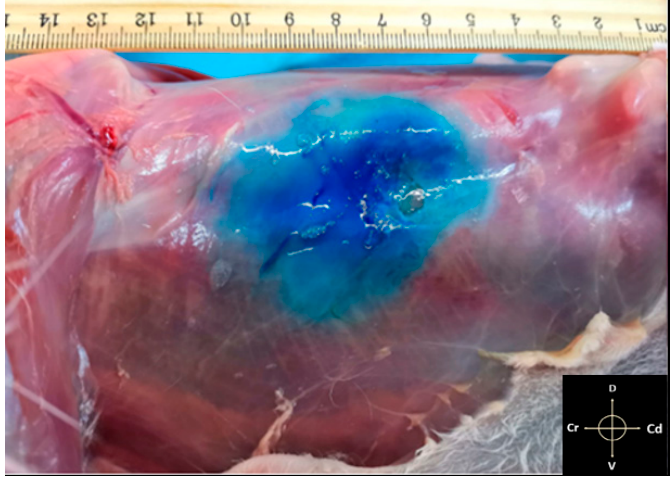
Figure 5. Lateral view of the abdominal wall after dissection of the skin and subcutaneous tissue. it is possible to observe the underlying tissues stained by methylene blue. The measurements from the last rib until the iliac crest were carried out. Arrows indicate cranial (Cr), caudal (Cd), dorsal (D) and ventral (V) directions respectively.